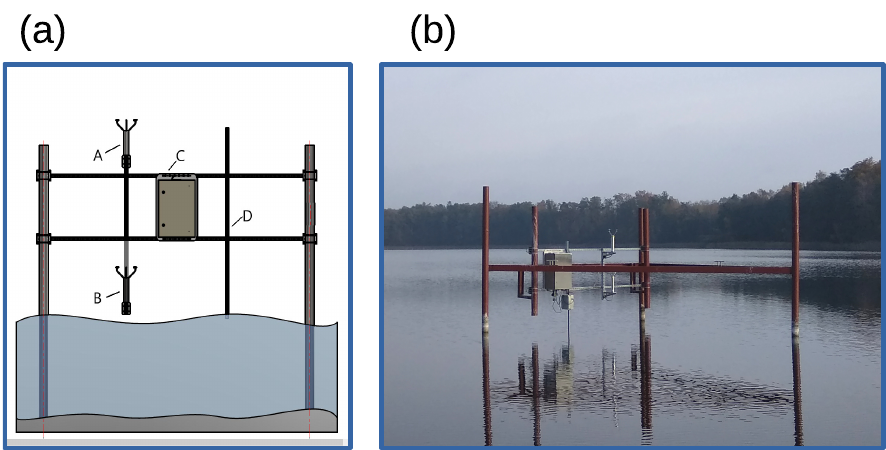
Figure 3. Measurement device: ( a ) design concept: A,B—ultrasonic anemometer, C—measurement box, D—wave sensor; ( b ) device mounted at the test